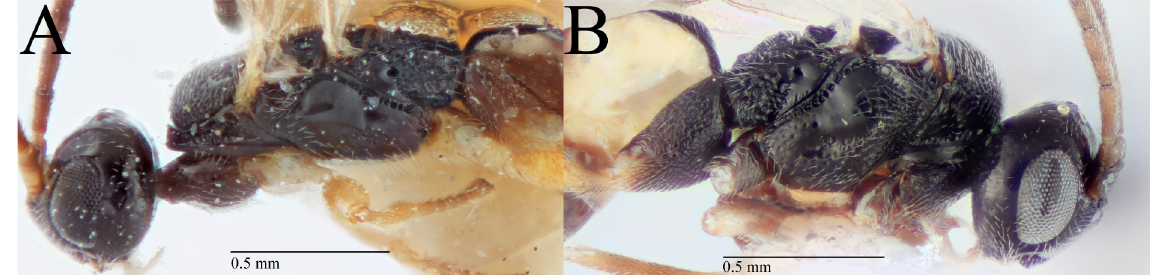
Fig. 5. A . Cotesia nonagriae (Olliff, 1893), head and mesosoma in lateral view. B . Cotesia ocellata sp. nov., head and mesosoma in lateral view (holotype, SAMA 32-44404).